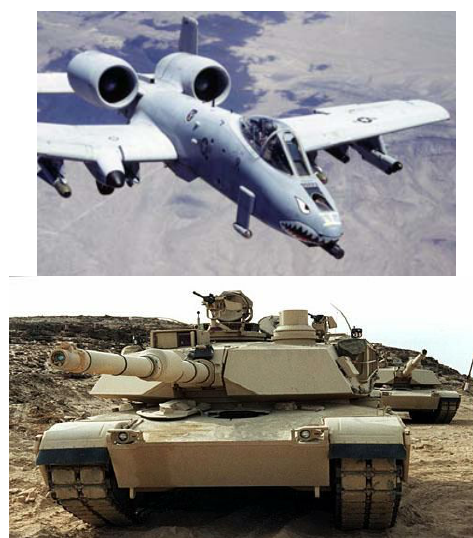
Figure 1 – Means for the application of DUA: A-10 Thunderbolt II aircraft and tank Рисунок 1 – Средства для применения БОУ : авиация А -10 Thunderbolt II и танк Abrams M1A2 Слика 1 – Средства за примену МОУ : ваздухоплов А -10 Thunderbolt II и тенк Abrams